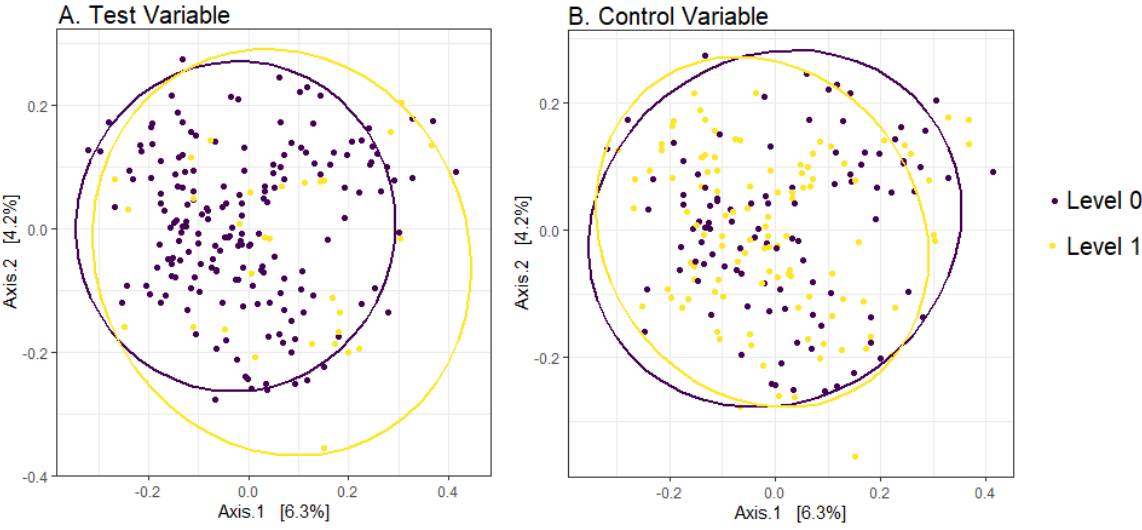
Figure 3. Human Gut Microbiome Beta Diversity by Level of the Simulated Variables. Bray–Curtis dissimilarity distance (beta diversity) shown using multidimensional scaling (MDS) ordination plots of ( A ) the test variable, and ( B ) the control variable. Data points represent individual observations. Data points closer together represent gut microbiome composition that is more similar, while data points farther apart represent gut microbiome composition that is more different. Data come from the Human Microbiome Project I with simulated test and control variables.